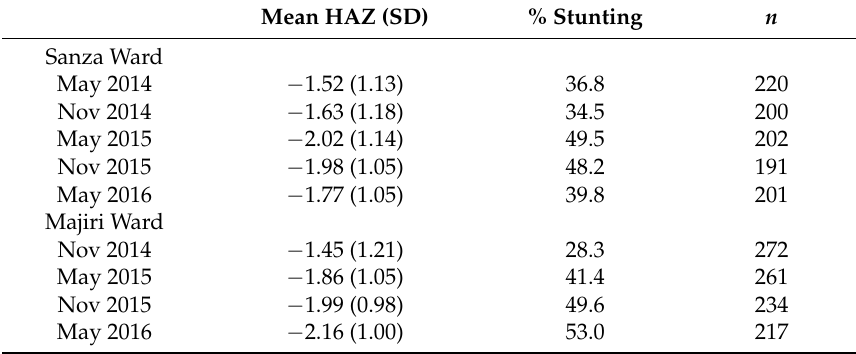
Table 4. Overview of height-for-age Z-scores (HAZ) and the percentage of stunting amongst enrolled children, by ward and by data collection period.